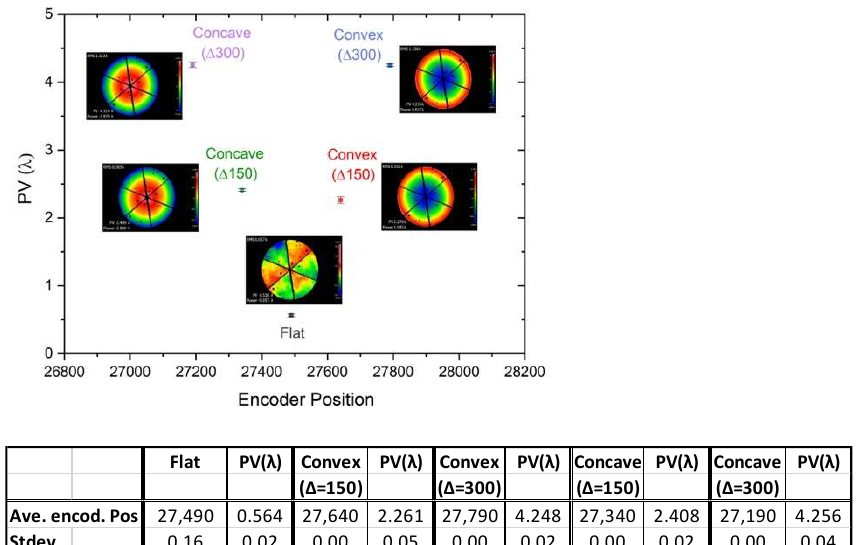
Figure 10. Graphical and tabular representation of the actuation sequence for the cases described above. Delta values refer to the change in encoder position from the flat state.